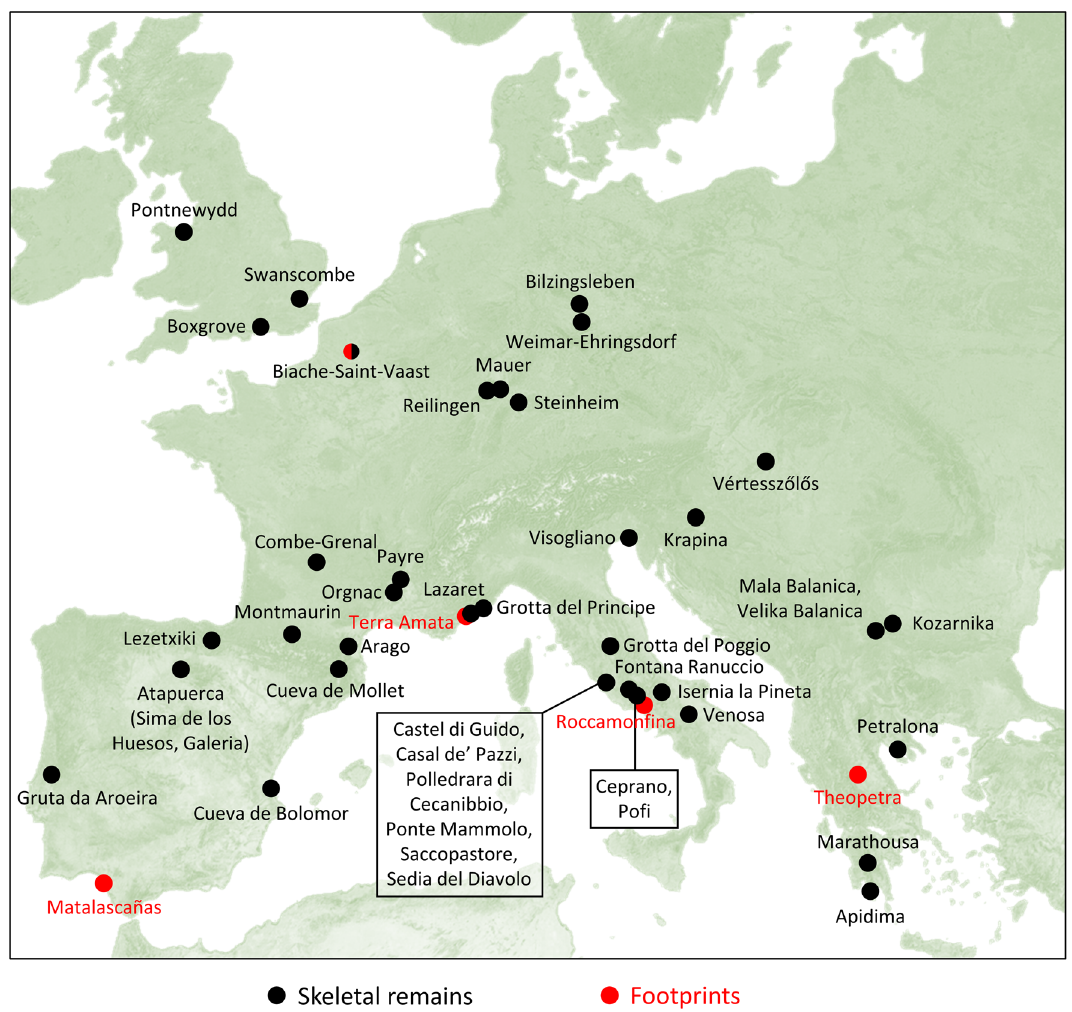
Figure 9. Geographical distribution of the main palaeoanthropological sites for the European Middle Pleistocene. Only those containing skeletal and ichnological assemblages are represented. The map was created from a free template (https:// commo ns. wikim edia. org/ wiki/ File: Europe_ satel lite_ image_ locat ion_ map. jpg). The legends were added using Inkscape (v.1.0.2, https:// inksc ape.